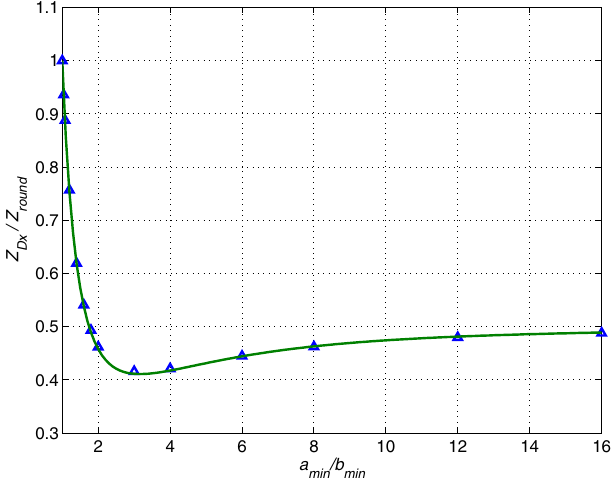
FIG. 13. (Color) Zero-frequency horizontal impedance from GDFIDL (symbols) and from first-order perturbation theory Eq. (3.30) (solid